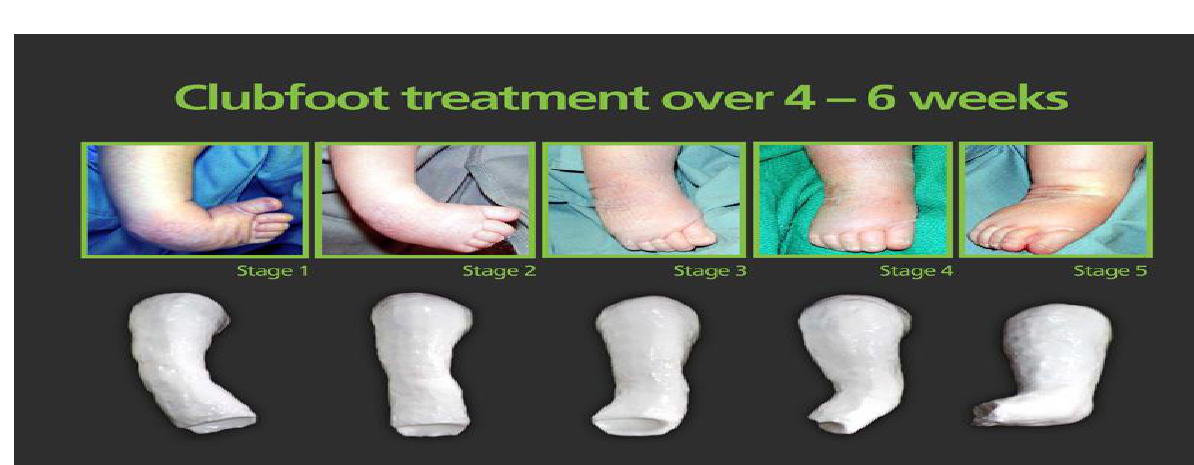
Figure: (2) Appearance of casts and foot Group Group A Group B Total number of patients Corrected patients 24 patients Not corrected patients